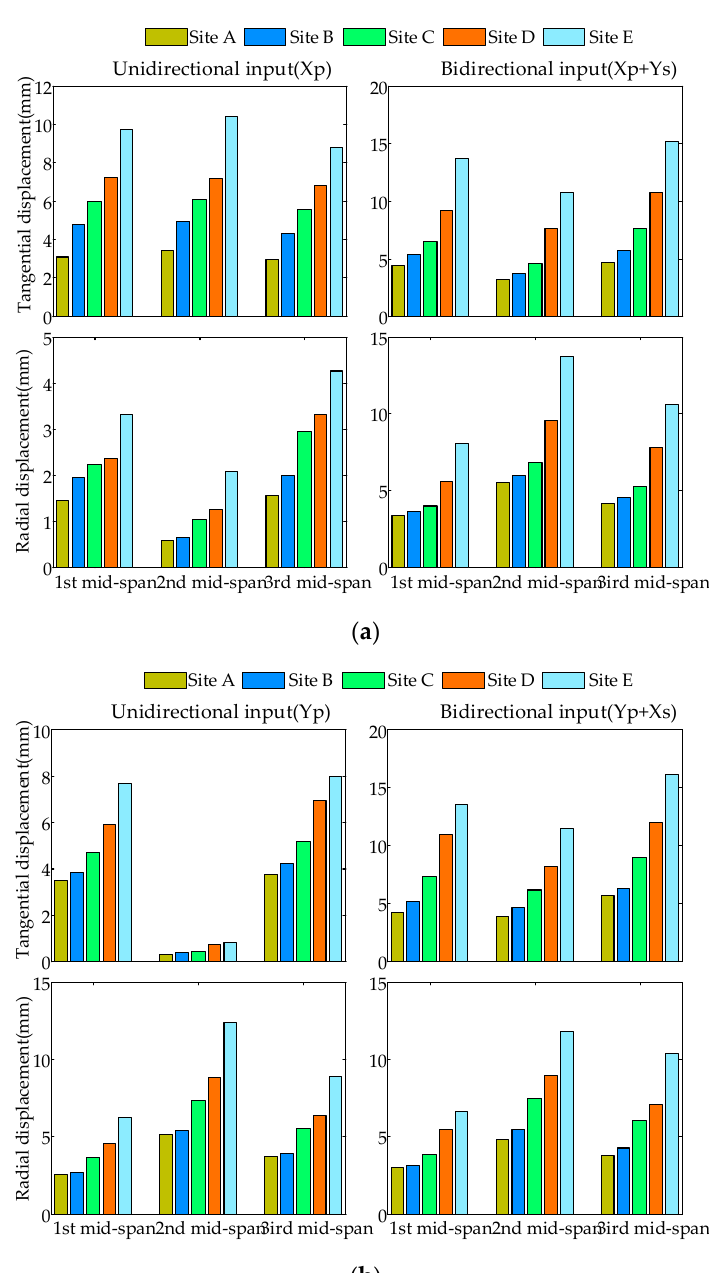
Figure 10. Mid-span displacement peak (unit: mm): ( a ) position A: curved bridge parallel to the direction of the principal ground motion; ( b ) position B: curved bridge perpendicular to the direction of the principal ground motion.